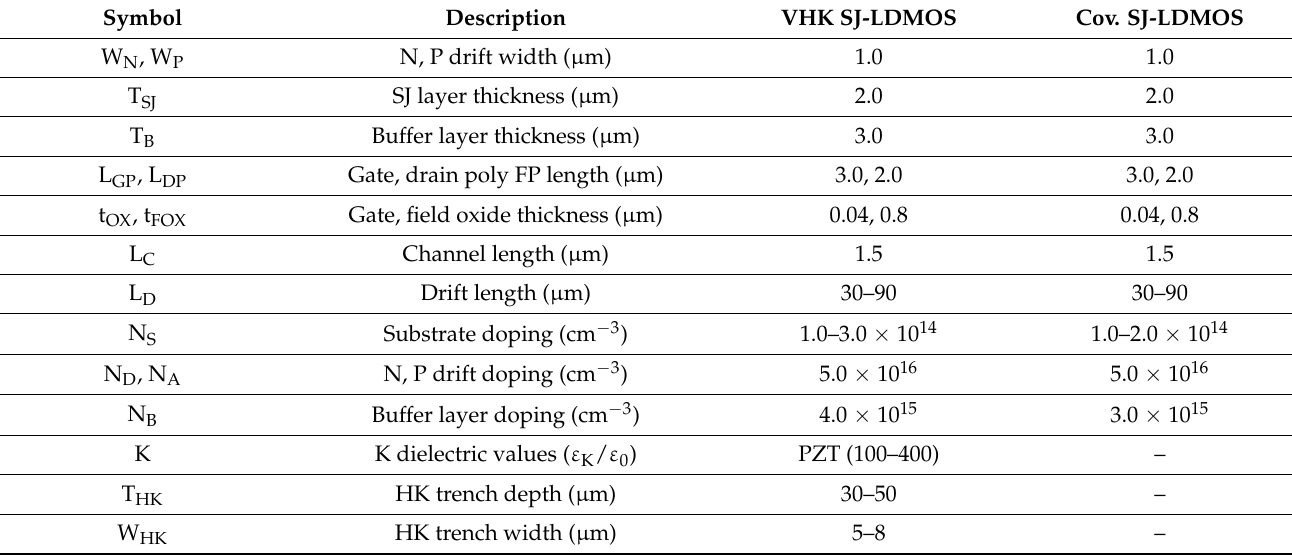
Table 1. Device parameters in the simulation.